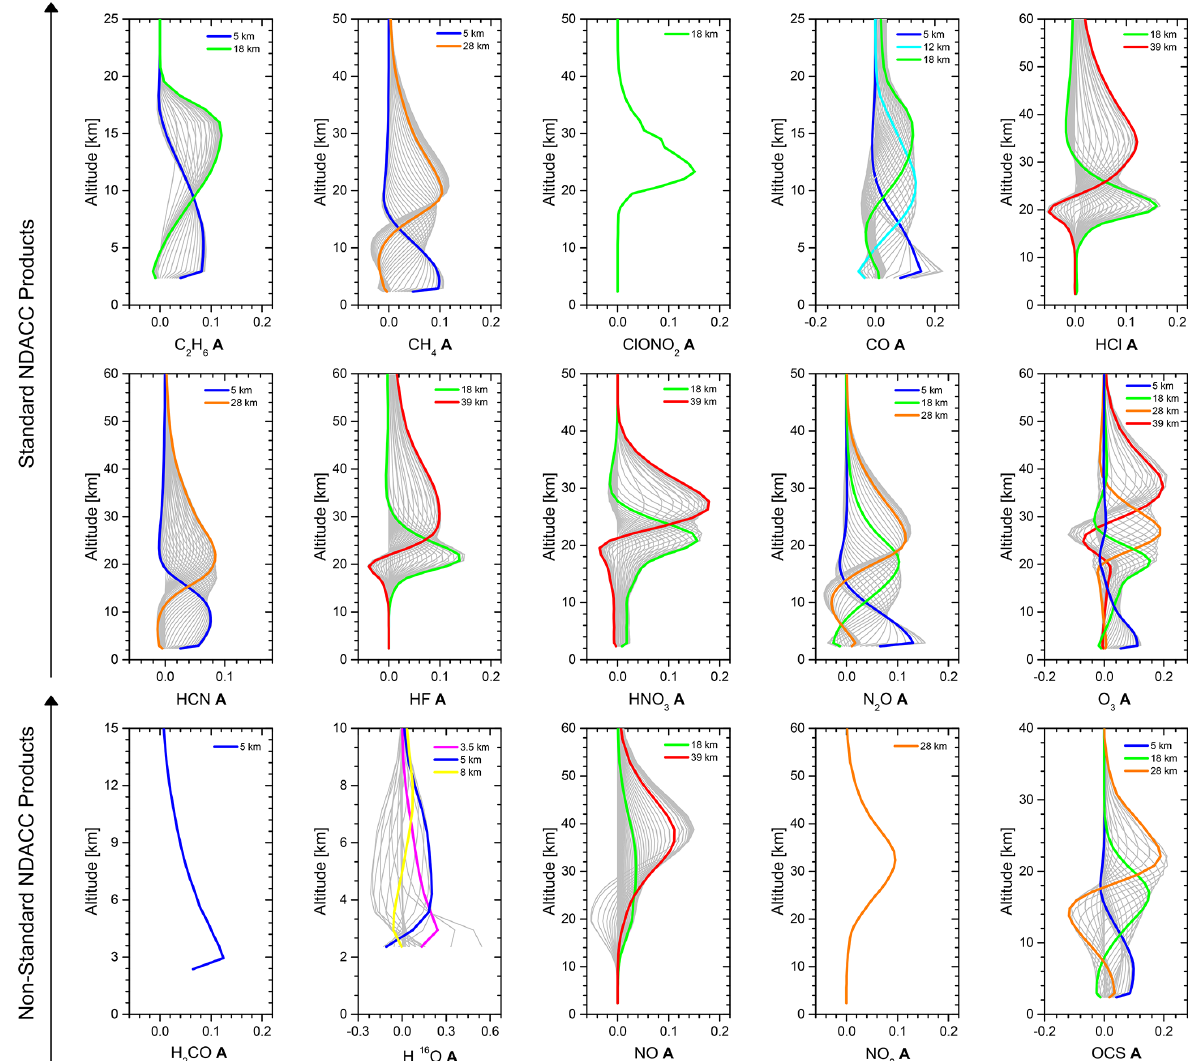
Figure 3. Example of the averaging kernel ( A ) rows, on a logarithmic scale, for standard and non-standard NDACC products for typical measurement conditions at IZO (spectra taken on 20 July 2013 at a solar zenith angle of ∼ 30 ◦ ). Note that for H 2 O, only the A rows of the main water vapour isotopologue (H 16 O) are shown. Coloured lines represent A rows at altitudes representative of the layers discernible by 2 the FTIR instrument. For a better representation, the ordinate limit for each product has been adapted depending on whether the trace gas has a significant contribution in the middle–upper stratosphere ( y limit of 40, 50, or 60km) or is predominantly distributed in the troposphere– lower stratosphere ( y limit of 10, 15, or